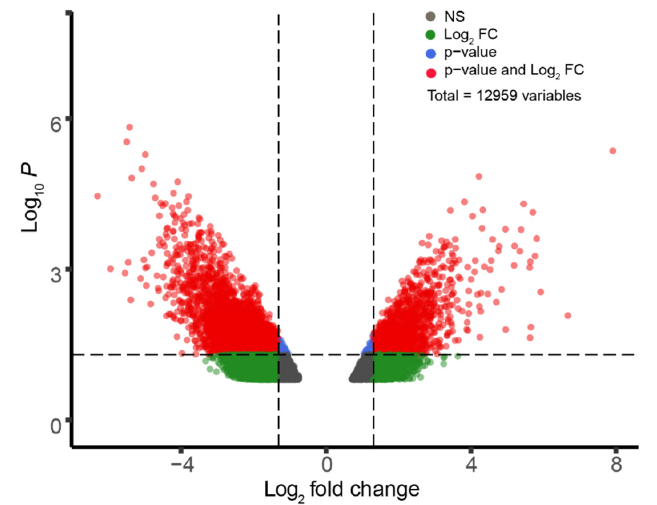
Figure 2. Gene expression comparison between oculomotor and spinal tissue from healthy subjects. Volcano Plot depicting differentially expressed genes between Oculomotor and Lumbospinal tissue from GSE40438, discriminated based on p-value and log2 (fold-change) at an α level of 0.05 and logFC cutoff of 1.3. The colored dots correspond to individual genes whose expression differences were significant based on both p and logFC value (red dots), only p-value (blue dots), only logFC (green dots), or not significant (grey dots) in either.